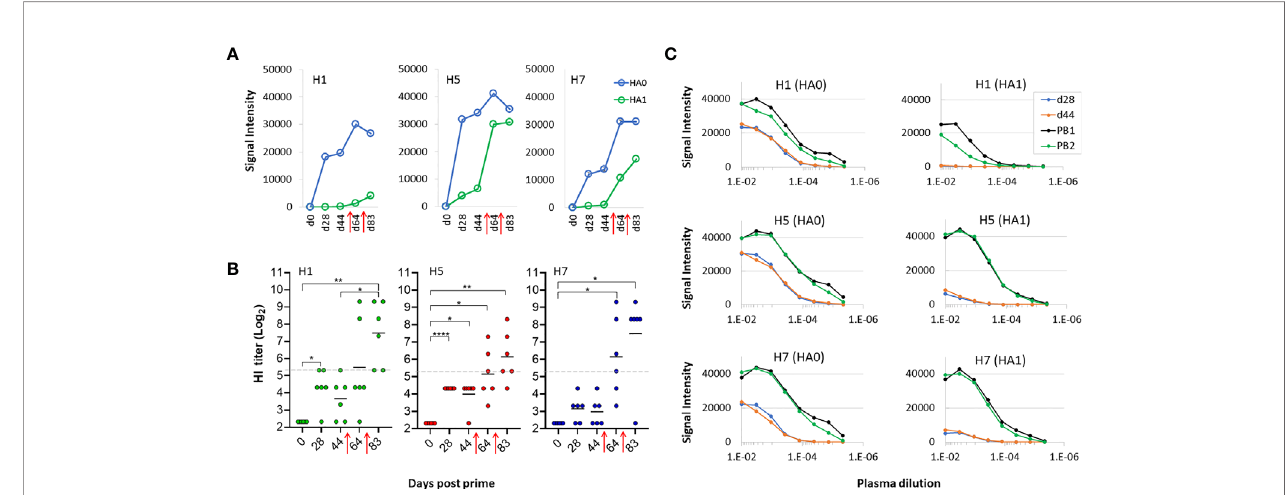
FIGURE 6 | Boosting is required to generate virus neutralization after receiving trivalent vaccine. (A) means of signals at different time points for HA0 and HA1 variants of H1, H5 and H7 after administration of trivalent vaccine. (B) HI assay titers of individual sera used in panels (A, B) against PR8 reassortant in fl uenza viruses expressing Cal09 H1, VN04 H5 and AH13 H7, respectively. Horizontal dotted line, 1/40 dilution cutoff (log-2 of 40 = 5.32) (C) serial dilutions of plasma from a representative mouse to determine titers at different time points using microarrays; shown are means of H1, H5 and H7 variants after serial dilutions. All data are representative of two separate experiments. PB1, post fi rst boost; PB2, post second boost; red arrows, boosts. ****P < 0.0001; ***P ≤ 0.001; **P ≤ 0.01; *P <